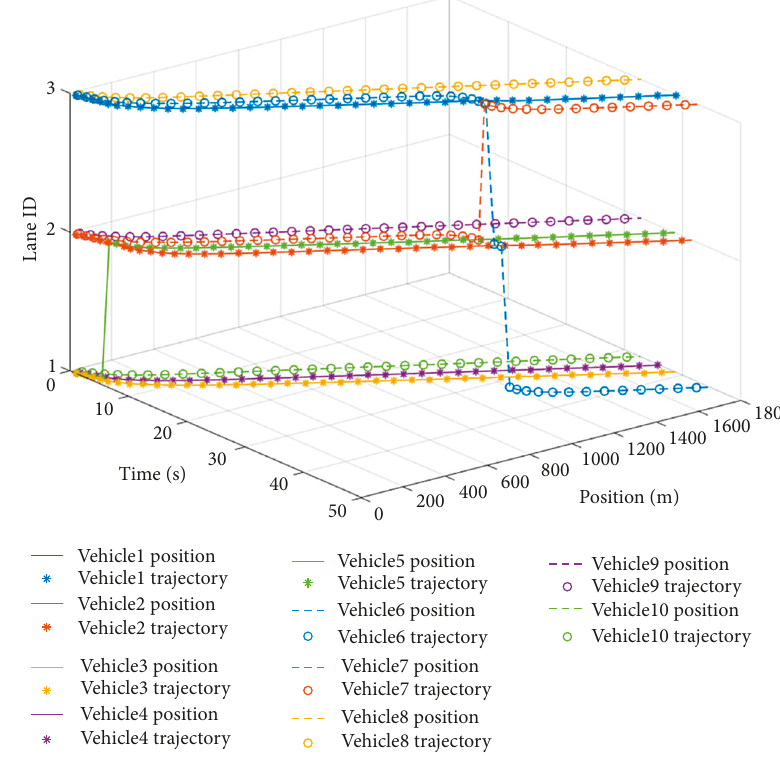
Figure 7: Optimal vehicle trajectories.